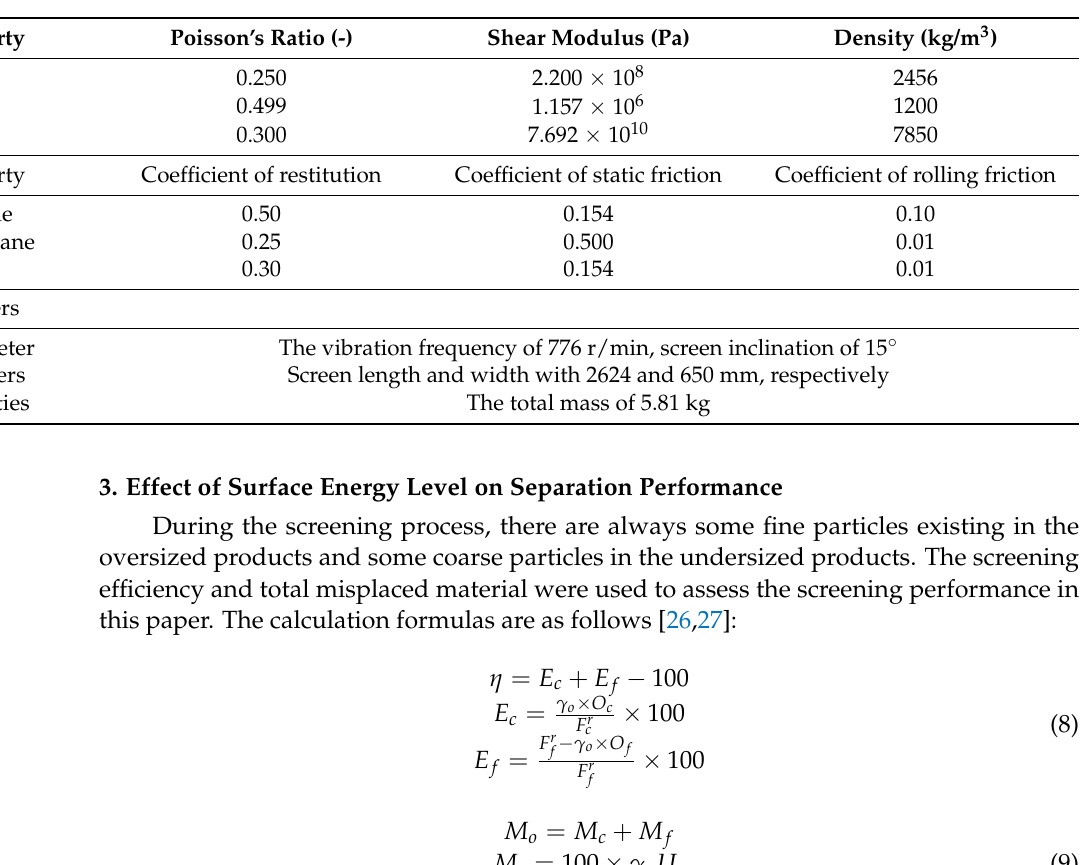
Table 2. Modeling condition in